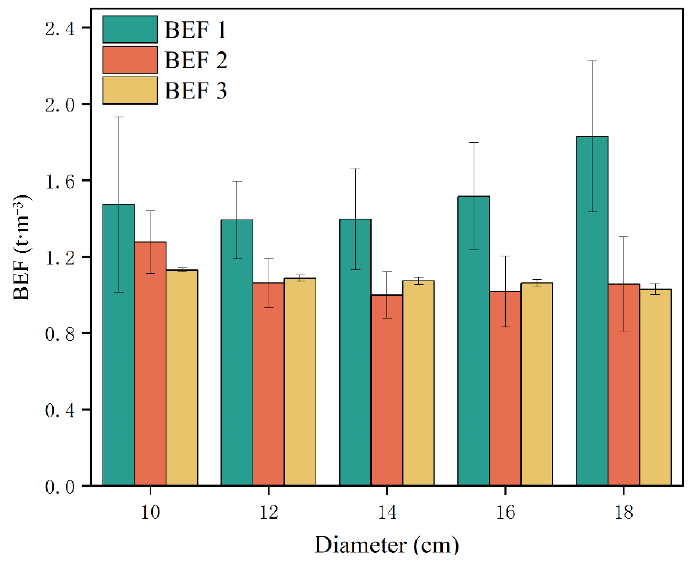
Figure 9. Comparison of BEF values as calculated by different methods.